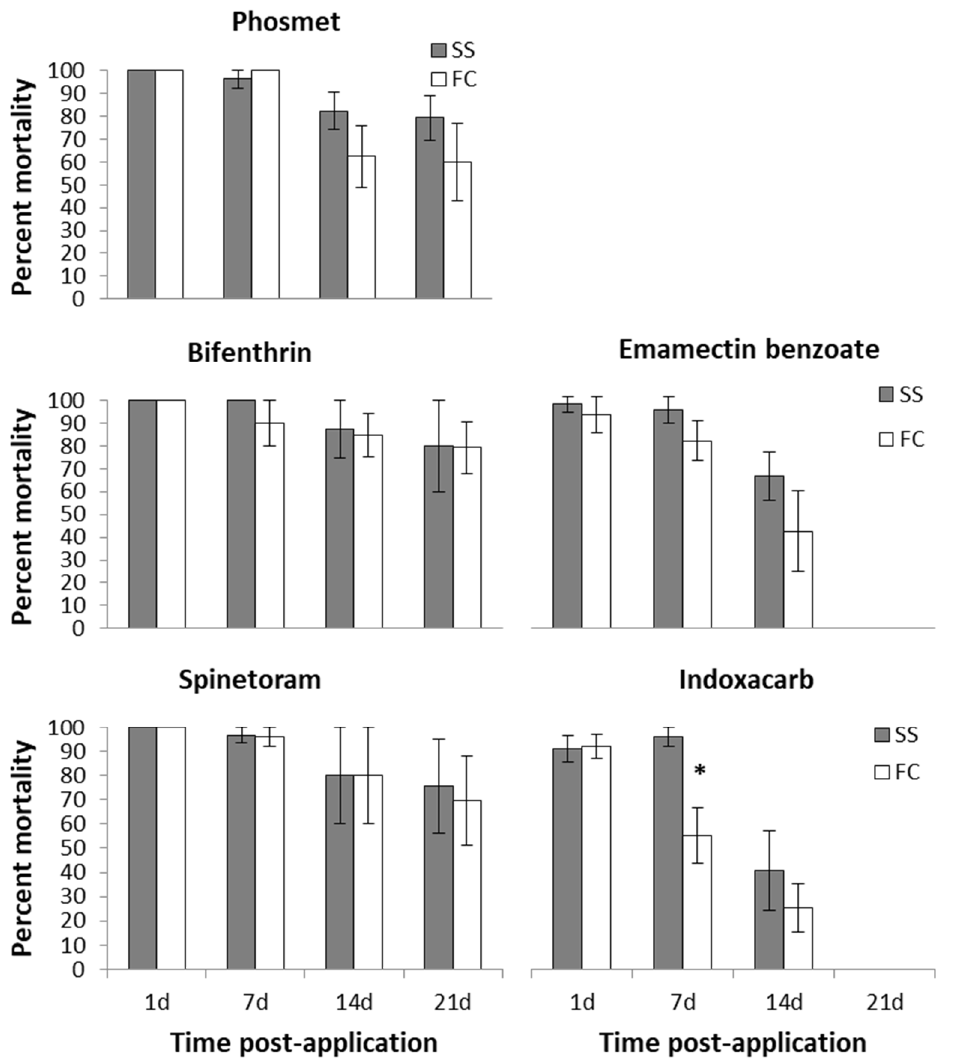
Figure 4. Mortality means ( ± SE) of the C. rosaceana 12–24 h-old larvae of the cherry population (FC) and susceptible population (SS) when exposed to cherry foliage collected at different post application intervals. An asterisk (*) means the mortality of the cherry population is significantly different from the mortality of the susceptible population at a given post-application interval ( α = 0.05).